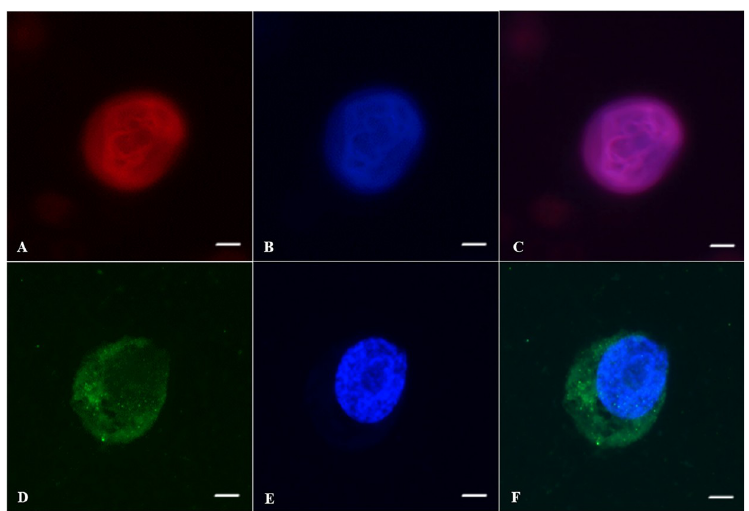
Fig 10. Oct4 and Boule in male germ cells from prepubertal cats after vitrification and culture. (A) Oct4 expression in the nucleus of pre-meiotic cell, (B) nucleus of pre-meiotic cell stained with Hoechst, (C) pre-meiotic cell merged images, (D) Boule expression in the cytoplasm of meiotic cell, (E) nucleus of meiotic cell stained with Hoechst, (F) meiotic cell merged images. Bar = 5 μ m.